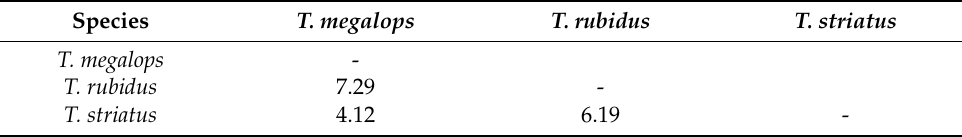
Figure 7. Factor map of the discriminant factors (DF) showing shape divergence of Tabanus megalops (red), T. rubidus (green), and T. striatus (blue). Together, the two DF represent 100% of the total discriminant space: 85% for DF1 (horizontal axis) and 15% for DF2 (vertical axis). Table 3. Validated classification based on the wing shapes of Tabanus megalops , T. rubidus , and T. striatus. Species Accuracy (Assigned/Observed) T. megalops